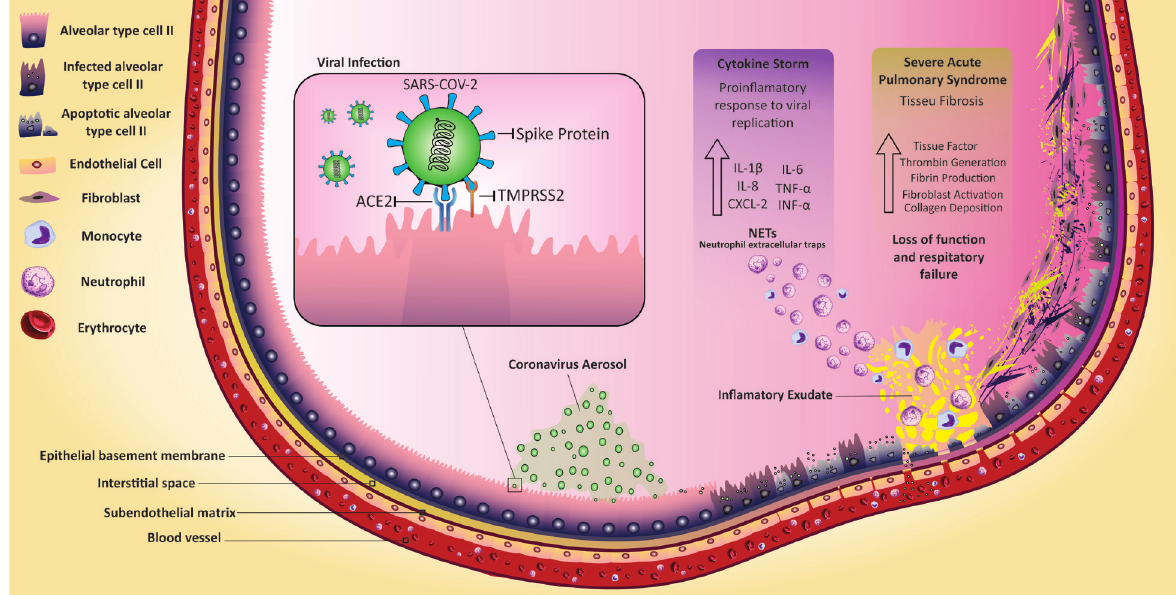
Figure 1. SARS-Cov-2 infection and inflammatory process. The New Coronavirus SARS-CoV-2, in its infection mechanism, binds to angiotensin-converting enzyme 2 (ACE2) via the receptor-binding domain (RBD) of its spike (S) glycoprotein. Proteolytic processing of the viral spike protein assisted by the host protease TMPRSS2 enables viral entry to human airway epithelial cells. The cytopathic effects that follow viral infectivity and replication lead to an intense inflammatory response with increased pro-inflammatory cytokines. These chemical mediator acts by promoting the cytoskeletal reorganization within endothelial cells allow the plasma proteins and leukocytes to leave the circulation producing the inflammatory exudate. Excessive deposit of fibrin in the lungs provides an ideal environment for fibroblast adhesion and proliferation, corroborating to an increase in collagen deposition in the alveolar space and the onset of a fibrotic response that can generate a loss of function and respiratory